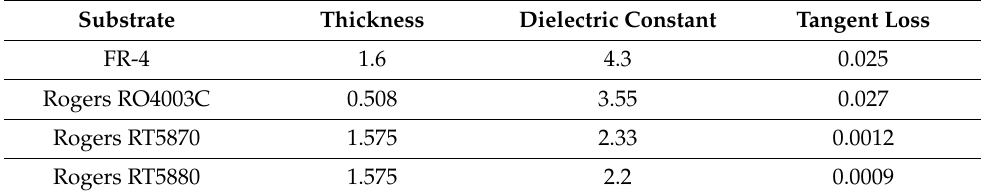
Table 2. The properties of the substrate materials.